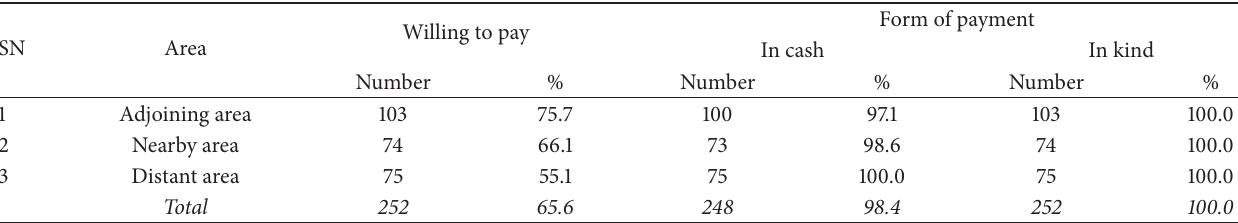
Table 10: HHs willing to pay for wetland conservation.